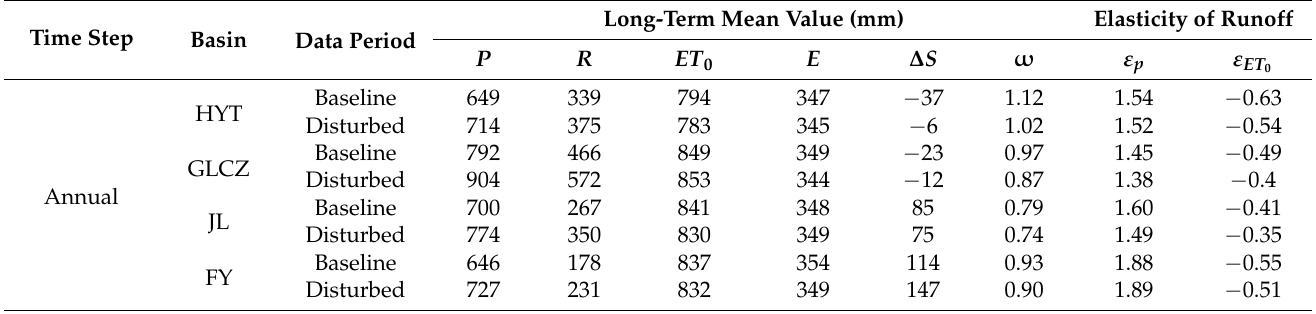
Table 3. Hydroclimatic characteristics and elasticity of runoff for the four sub-basins in the SSR